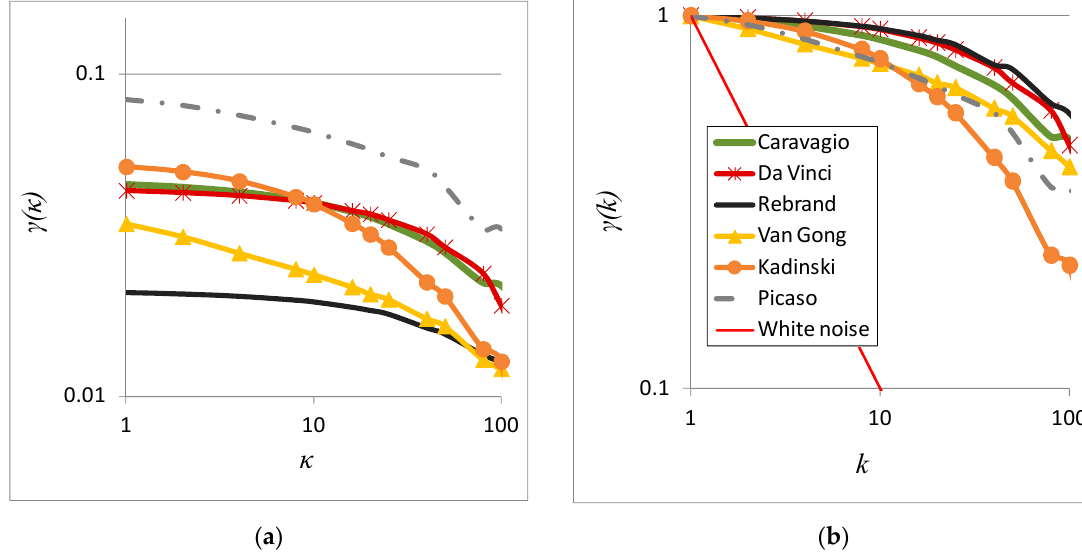
Figure 5. ( a ) Averages of the climacograms of the artworks; ( b ) Averages of the standardized climacograms of the artworks.